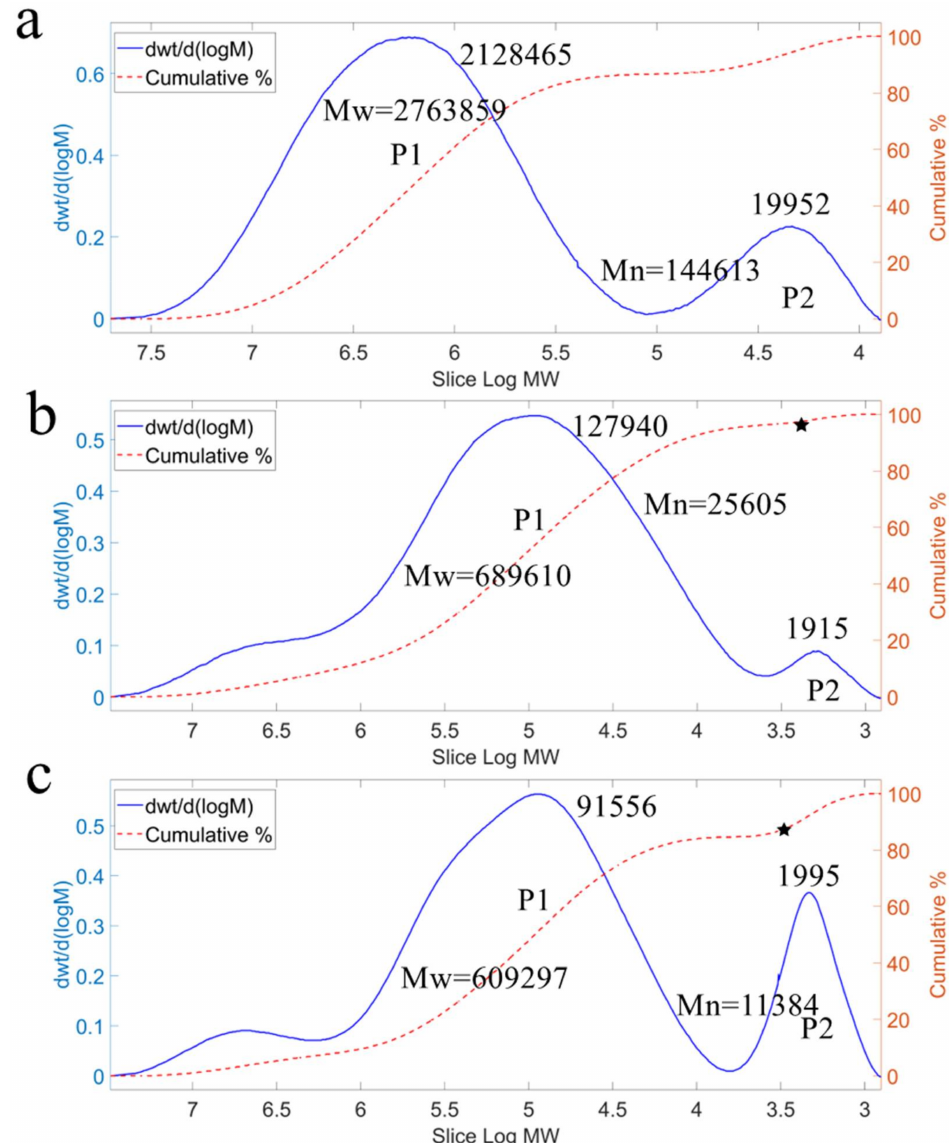
Figure 7. GPC profiles of levan products synthesized by different forms of levansucrases. ( a ) levan produced by Lev; ( b ) levan produced by Lev-f; ( c ) levan produced by Lev-a; Mw = weight average molecular weight; Mn = number average molecular